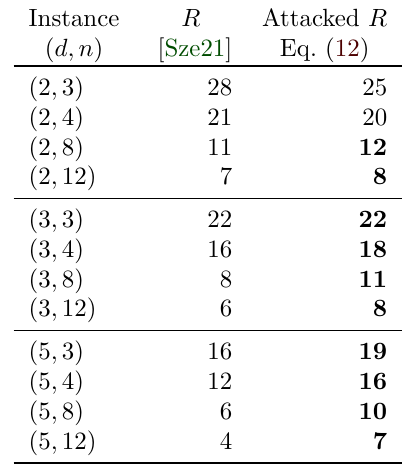
Table 3: Number of attacked rounds of Grendel when considering the univariate root- finding approach. Bold numbers indicate that the attack breaks the full-round versions of Grendel considering the round numbers proposed in the original paper [Sze21]. In this table, κ = 128 and p ≈ 2 256